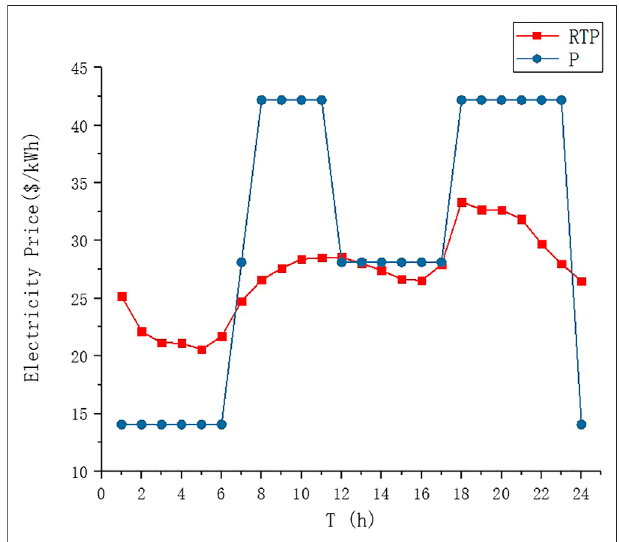
FIGURE 4 | Comparison chart of real-time electricity price and tiered electricity